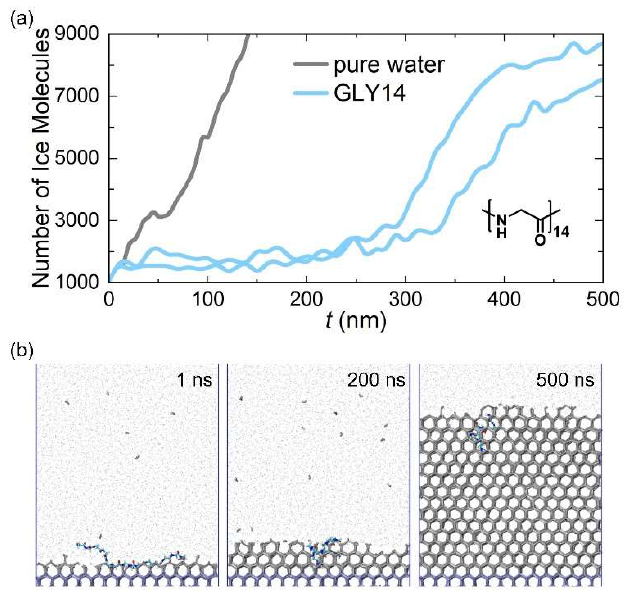
Figure 5. GLY14 can also bind to ice surfaces. ( a ) The structure and ice growth inhibition perfor- mance of GLY14. ( b ) Representative snapshots of simulations (1 ns, 200 ns and 500 ns, respectively). The free ice and liquid water molecules are shown by gray lines and gray dots, respectively. The GLY14 is represented as colorful licorice.